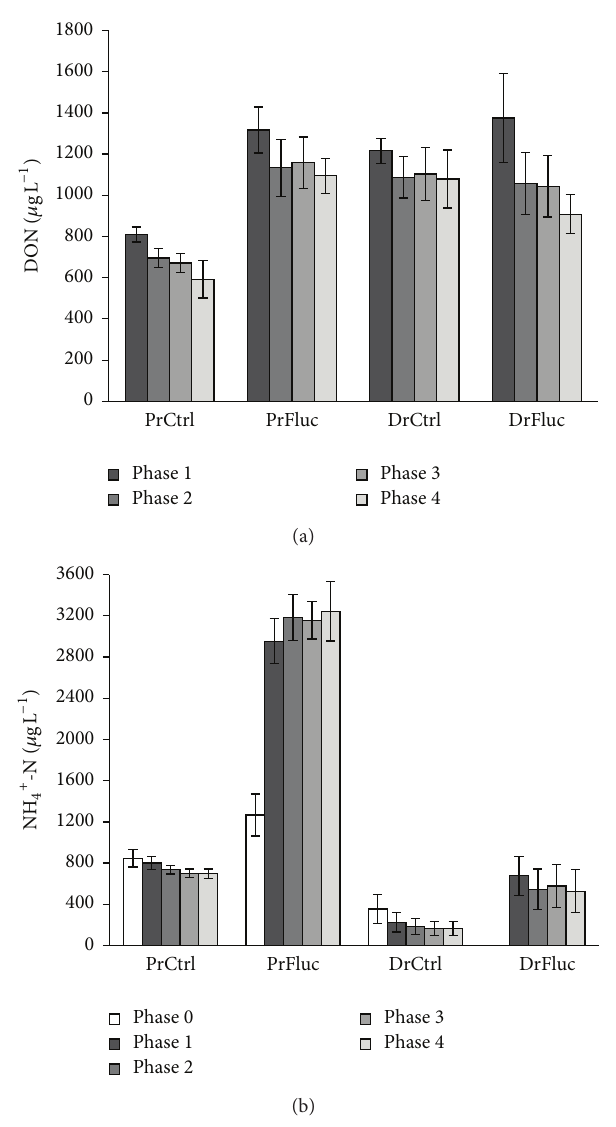
Figure 2: (a) Mean ( ± SE) concentrations of DON in different exper- imental groups at phases 1–4. 𝑁 = 5 except at phases 3 and 4 in DrCtrl, where 𝑛 = 4 . (b) Mean ( ± SE) concentrations of NH 4+ -N in different experimental groups at phase 0, that is, at the end of the lowwatertable,andatphases1–4,thatis,duringthehighwatertable. 𝑁 = 5 exceptatphase0inPrFluc,where 𝑛 = 4 ,andinDrFluc,where 𝑛 = 0 . See the results of the statistical analyses from Tables 2 and 3. Pr = pristine, Dr = drained, Ctrl = control, and Fluc = fluctuating water